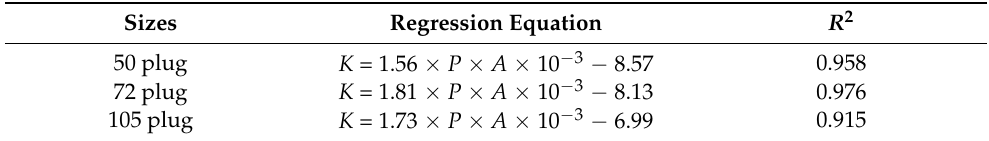
Table 6. The relationship between the matrix loss and the collision impact force of different specifica- tions of oil sunflower plug